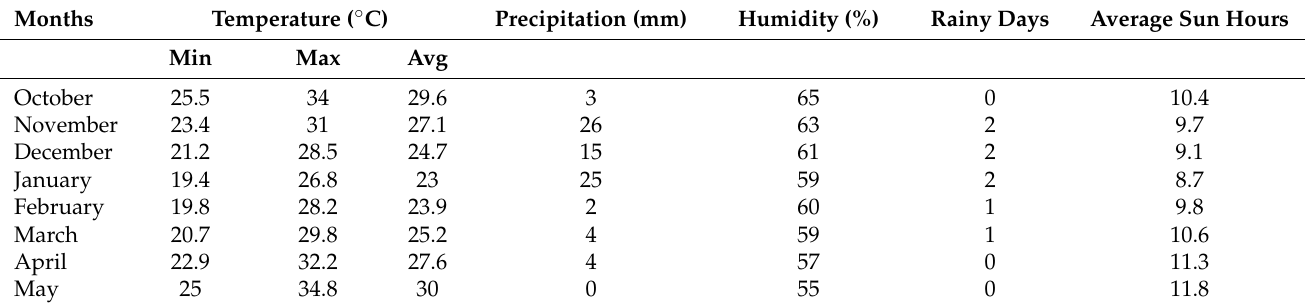
Table 2. Average meteorological data of research station during cropping seasons 2020–21 and